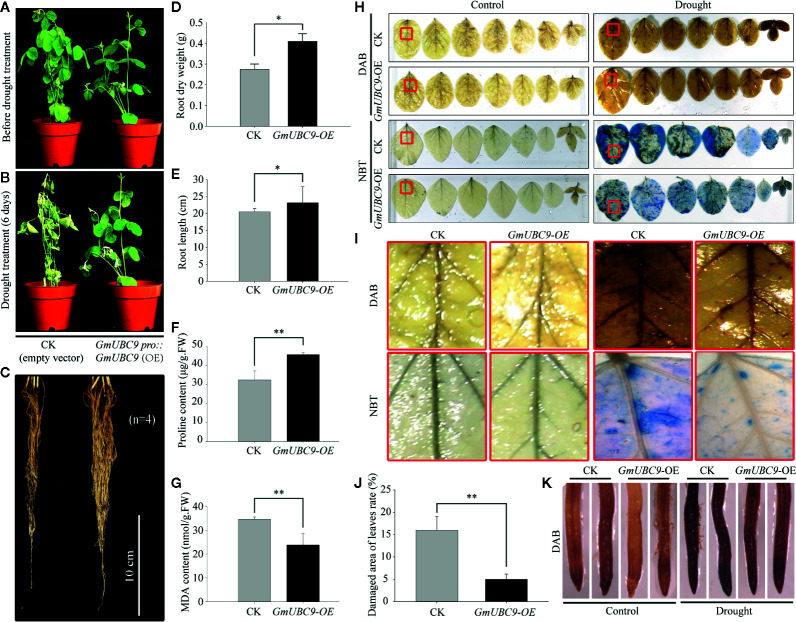

GmUBC9 enhances soybean hairy root drought tolerance. Seedlings (2–5 cm roots) were initially grown for 5 days under normal growth conditions, after which water was withheld for 6 days. Drought resistance phenotypes in CK and OE plants under drought conditions are shown (A) in aerial tissues before drought, (B) in aerial tissues after drought, and (C) in roots after drought. Root dry weight (D) and root length (E) of the water-stressed plants was monitored. The leaf contents of proline (F) and MDA (G) were detected in CK and OE plants under drought. DAB and NBT (H, I) CK and OE plant leaf staining following exposure to normal or drought or conditions for 6 days. Color depth corresponds to H2O2 and O2
− levels in leaves (H, I). The percentage of damaged area of the leaves of CK and OE plants following exposure to normal or drought or conditions for 6 days. (J). DAB (K) CK and OE plant root staining following exposure to normal or drought or conditions for 6 days. The data were means ± SDs of four independent biological replicates (n=4). Data are means and standard deviations from. *P < 0.05; **P < 0.01 vs. controls; Student’s t-test.